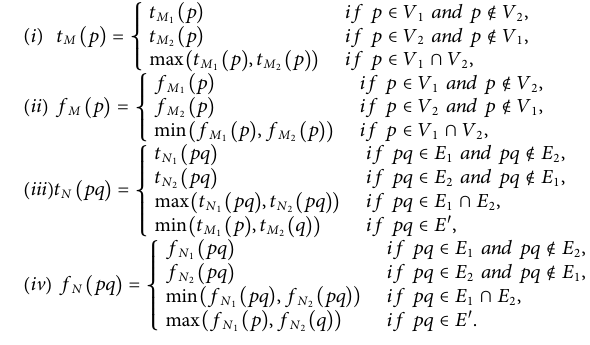
ζ Theorem 3.14. Suppose ζ 1 = ( M 1 , N 1 ) and 2 = ( M 2 , N 2 ) are two VGs. Then, ζ = ( M , N ) is the cross product of ζ 1 and ζ 2 if each LG ζ ( λ , δ ) is the cross product of ( ζ 1 ) ( λ , δ ) and ( ζ 2 ) ( λ , δ )